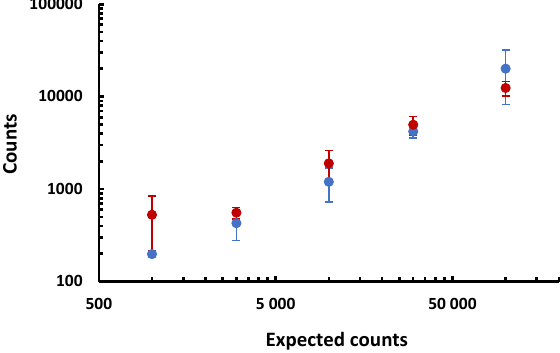
Figure 7. Experimental results of flow cytometry (in blue) compared with experimental results of the GMR test (in red). Mean values and standard deviations are